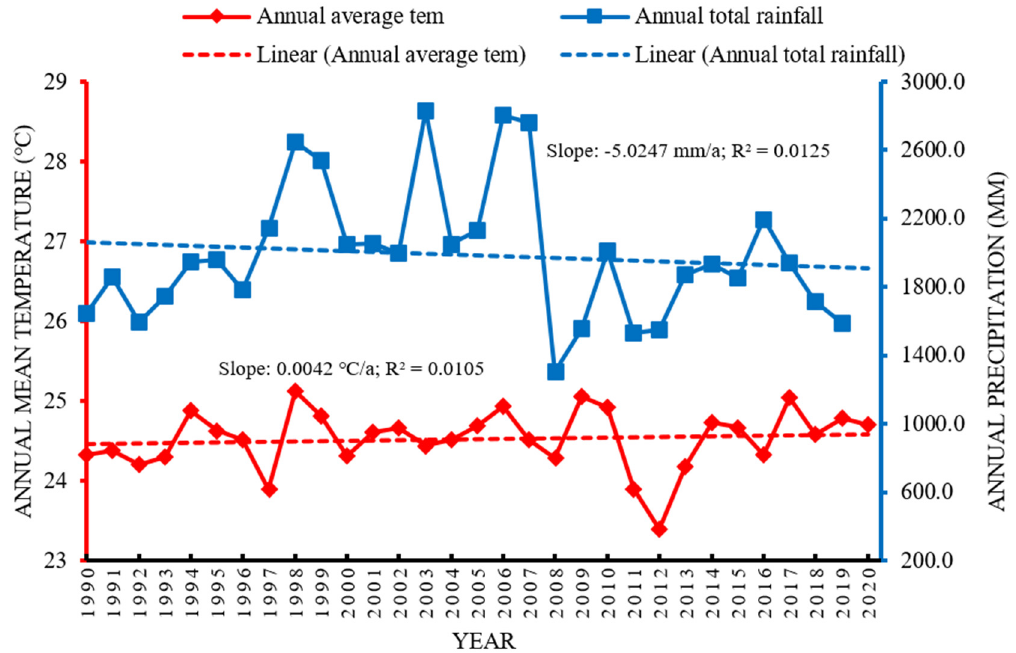
Figure 4. Temperature and precipitation trend in Tarai region of the GRB.